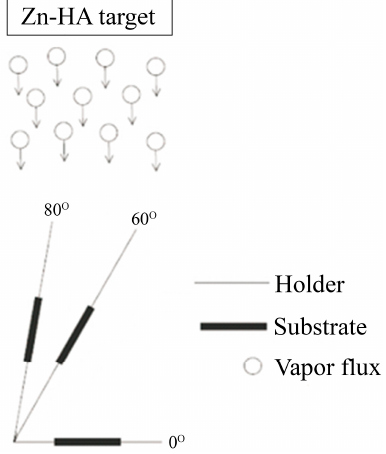
Figure 1. Schematic image of the deposition process of the Ti and Si samples with varying particle incidence angles at 0 ◦ , 60 ◦ , and 80 ◦ during the radiofrequency (RF) magneton sputtering of a Zn-substituted hydroxyapatite (Zn-HA) target with the arrows indicating the direction of the flux. The sample holder allows for the simultaneous placing of substrates at 0 ◦ , 60 ◦ , or 80 ◦ to ensure the same sputtering conditions for all the deposited